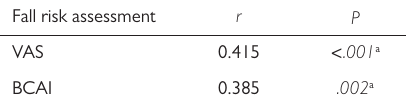
Table 4. The Correlation of Fall Risk Assessment with Clinical